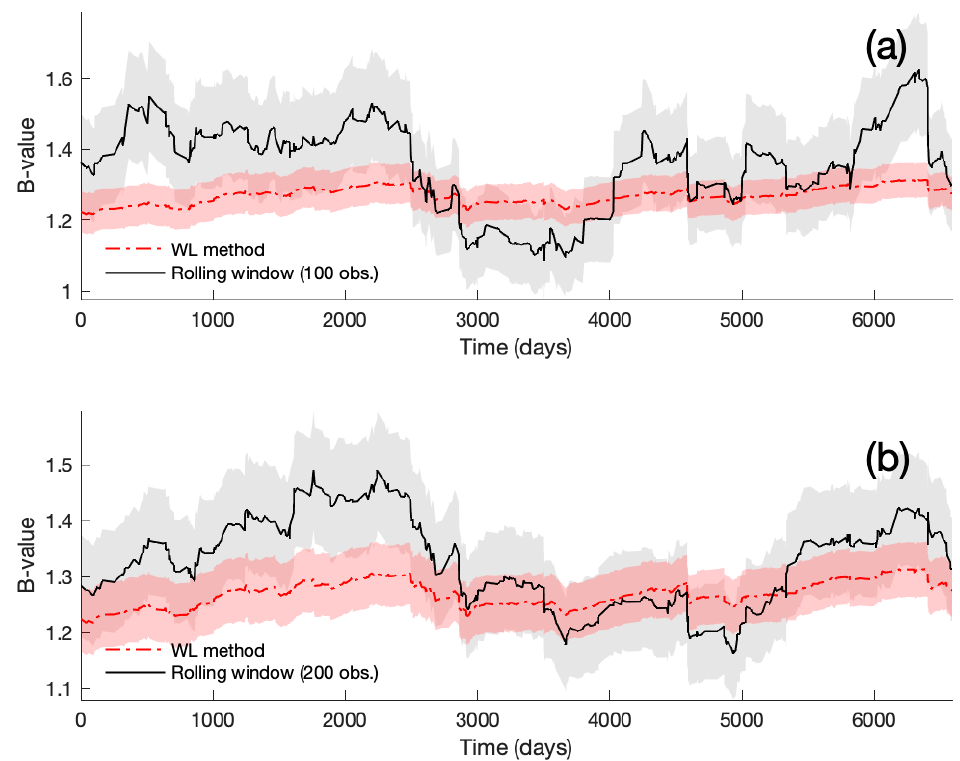
Figure 5. Comparison of the estimated b-value (with uncertainties, +/ − sigma, shaded areas) for the WL method (red) and rolling window (black) applied to the CMT testing dataset; panel ( a ) represents the rolling window method using 100 observations, and in panel ( b ) using 200 observations.